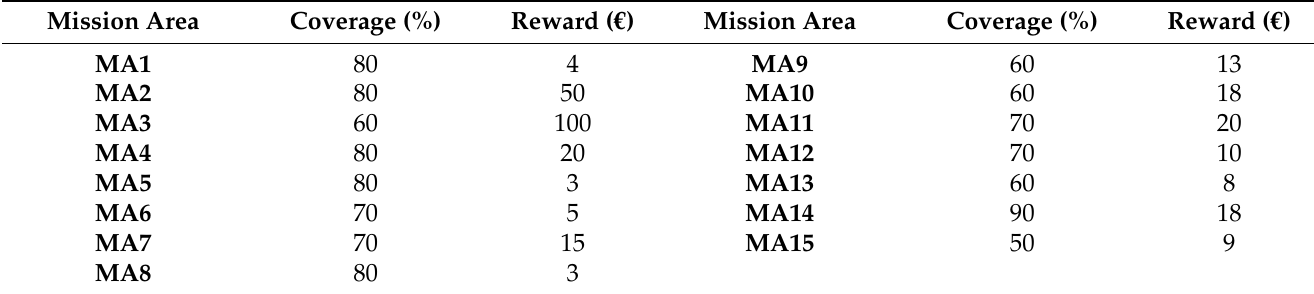
The rewards obtained for the successful monitoring of all LOI(s) of a MA are listed in Table A3, along with the image coverage of the ground required for the monitoring mission to be considered successful. Table A3. Rewards to be given for each MA ( × 10 3